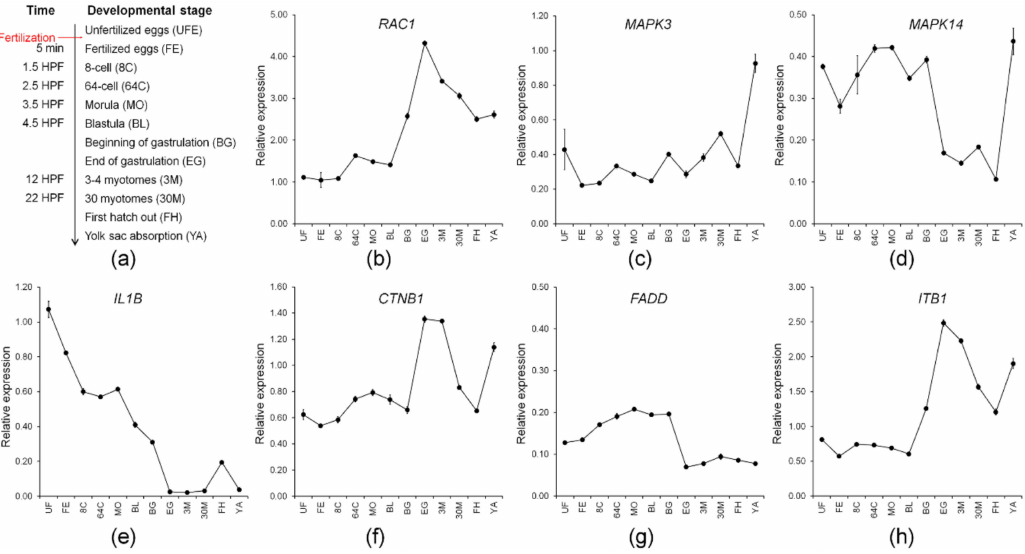
Figure 6. Transcriptional levels of identified maternal immune-related candidate genes during ontogeny of M. anguillicaudatus : ( a ) the ontogeny of M. anguillicaudatus , time for each developmental stage was represented by HPF (hours post-fertilization) and DPH (days post-hatching) and transcriptional levels of ( b ) RAC1 ; ( c ) MAPK3 ; ( d ) MAPK14 ; ( e ) IL1B ; ( f ) CTNB1 ; ( g ) FADD ; and ( h ) ITB1 . The results analyzed in statistics are shown in Table